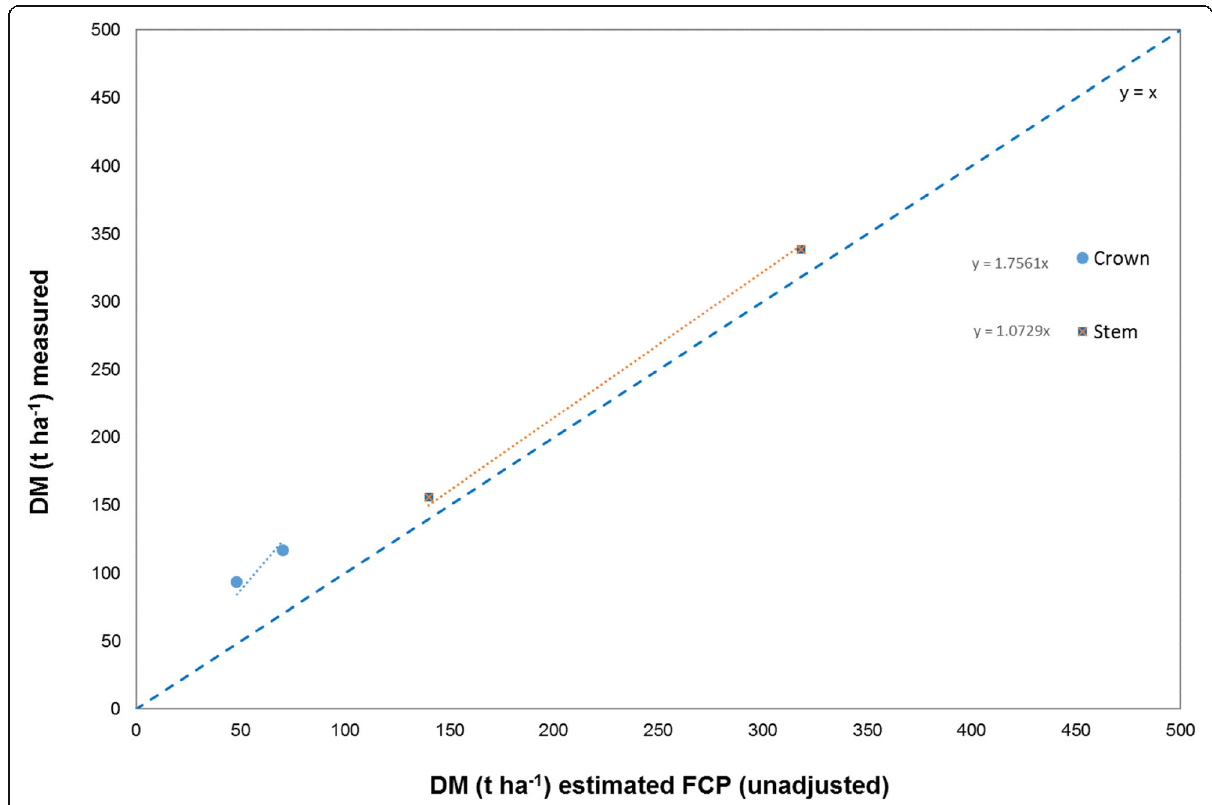
Fig. 5 Relationship between measured dry matter (DM) in Cupressus lusitanica stands and modelled dry matter estimates in stands of the same age, mean top height, basal area, stocking, and silvicultural regime from the Forest Carbon Predictor